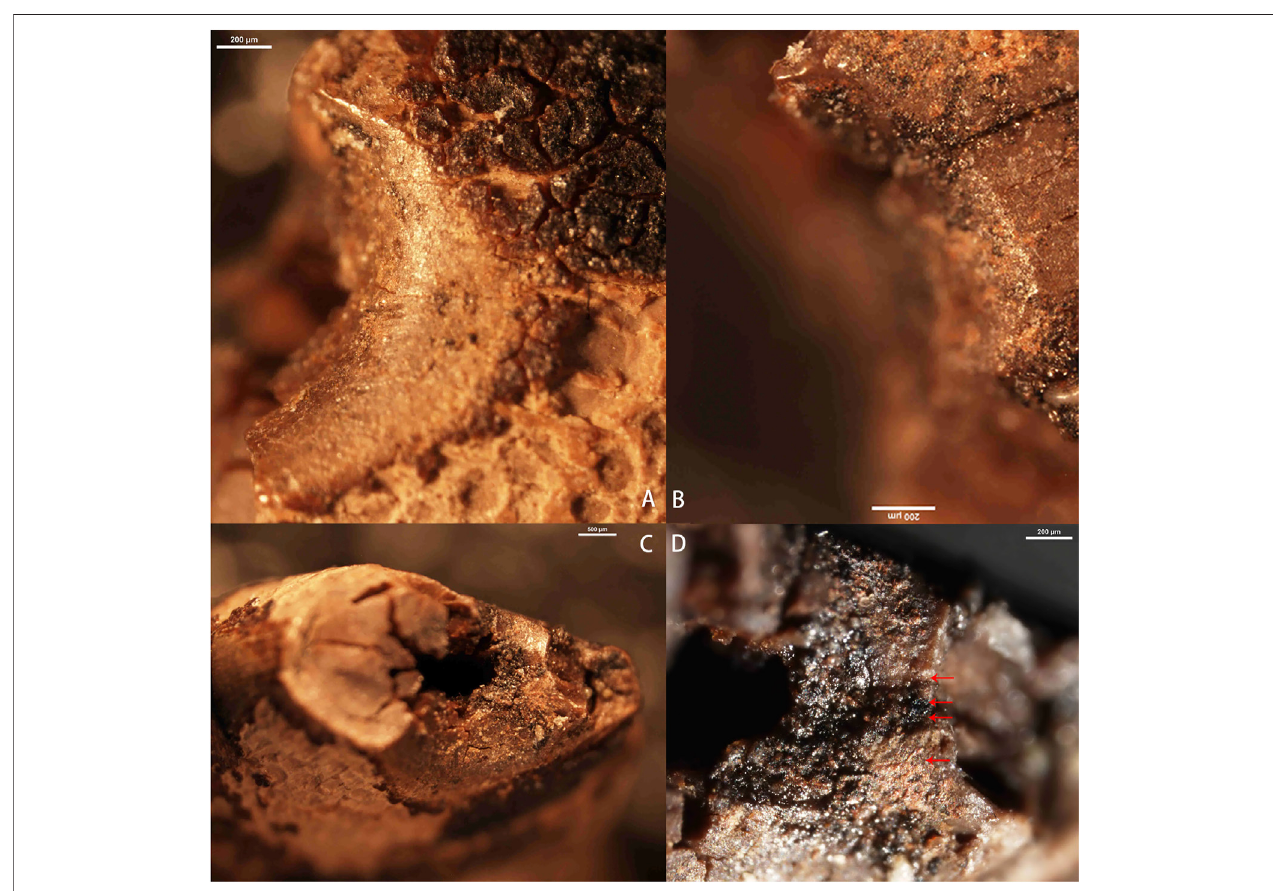
FIGURE4|(A) Conicalperforationonthelingualsurface; (B) Conicalperforation onthelabialsurface; (C) Remainingpartofthebrokenperforation; (D) Concentric striations in the middle part of the perforation surface. Scales: (A,B,D) 200 μ m, (C) 500 μ m.